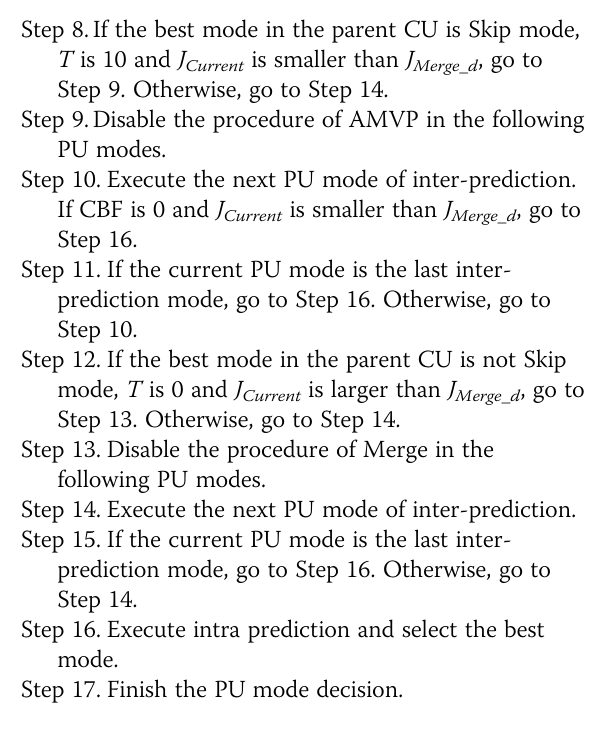
figuration settings of experimental environment. Table 3 describes the sequence information, including different resolutions, numbers of frames, and frame rates (FPS).